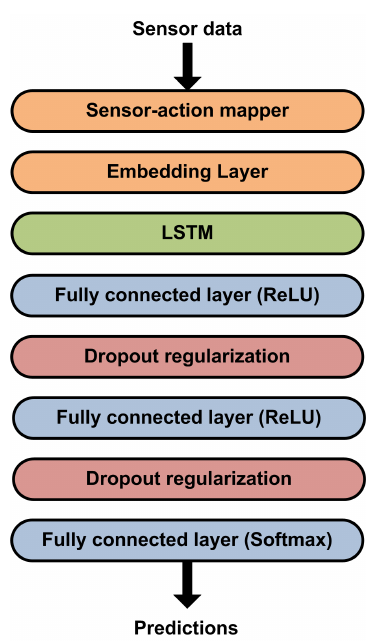
Figure 3. Long short-term memory network (LSTM) for behaviour